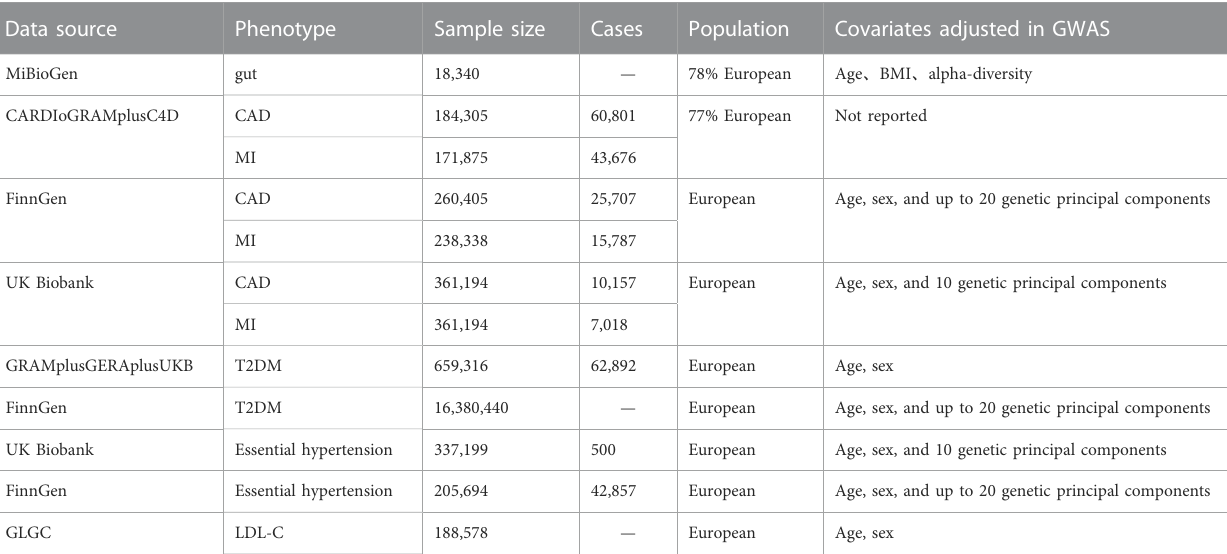
TABLE 1 Detailed information of data sources for